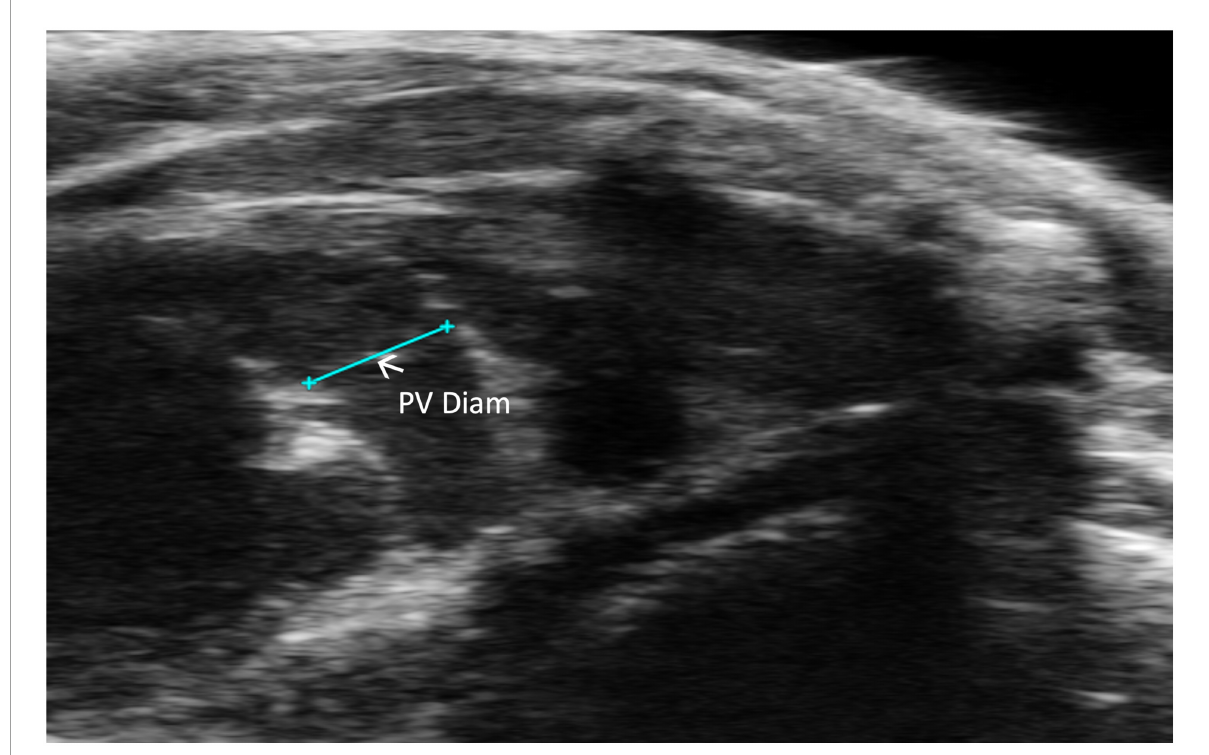
FIGURE7 Pulmonic valve (PV) diameter is acquired and analyzed in B-mode of the parasternal long axis (PLAX) view.